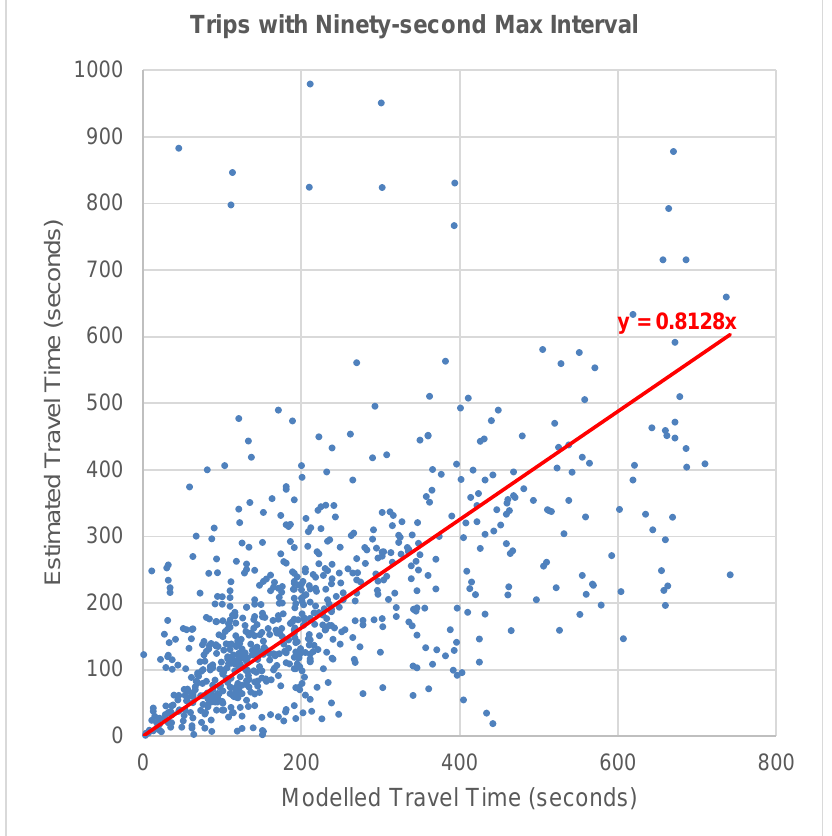
Figure 11. Estimated-observed travel time comparison for trips with 90-seconds max